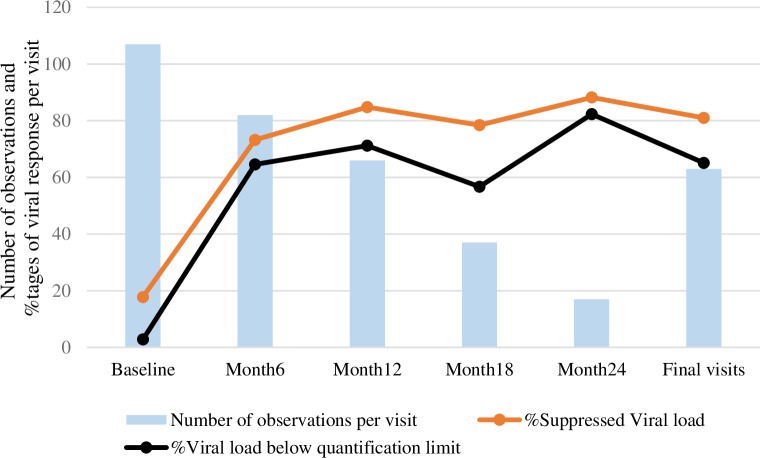
Time trends in suppressed and below quantification limit viral load among HIV-infected FSWs on ART, Benin.N: Number of observations per visit % Suppressed viral load: Proportion of participants with viral load <1000 copies/ml % Below quantification limit: Proportion of participants with viral load <50 copies/ml Final Visits: Included 63 participants with regular final visits from Month 6 onwards; excluded all final visits that occurred prior to M6.